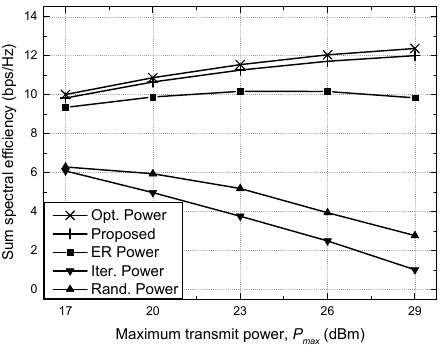
Figure 4. Sum spectral efficiency vs. maximum transmit power ( P max ).